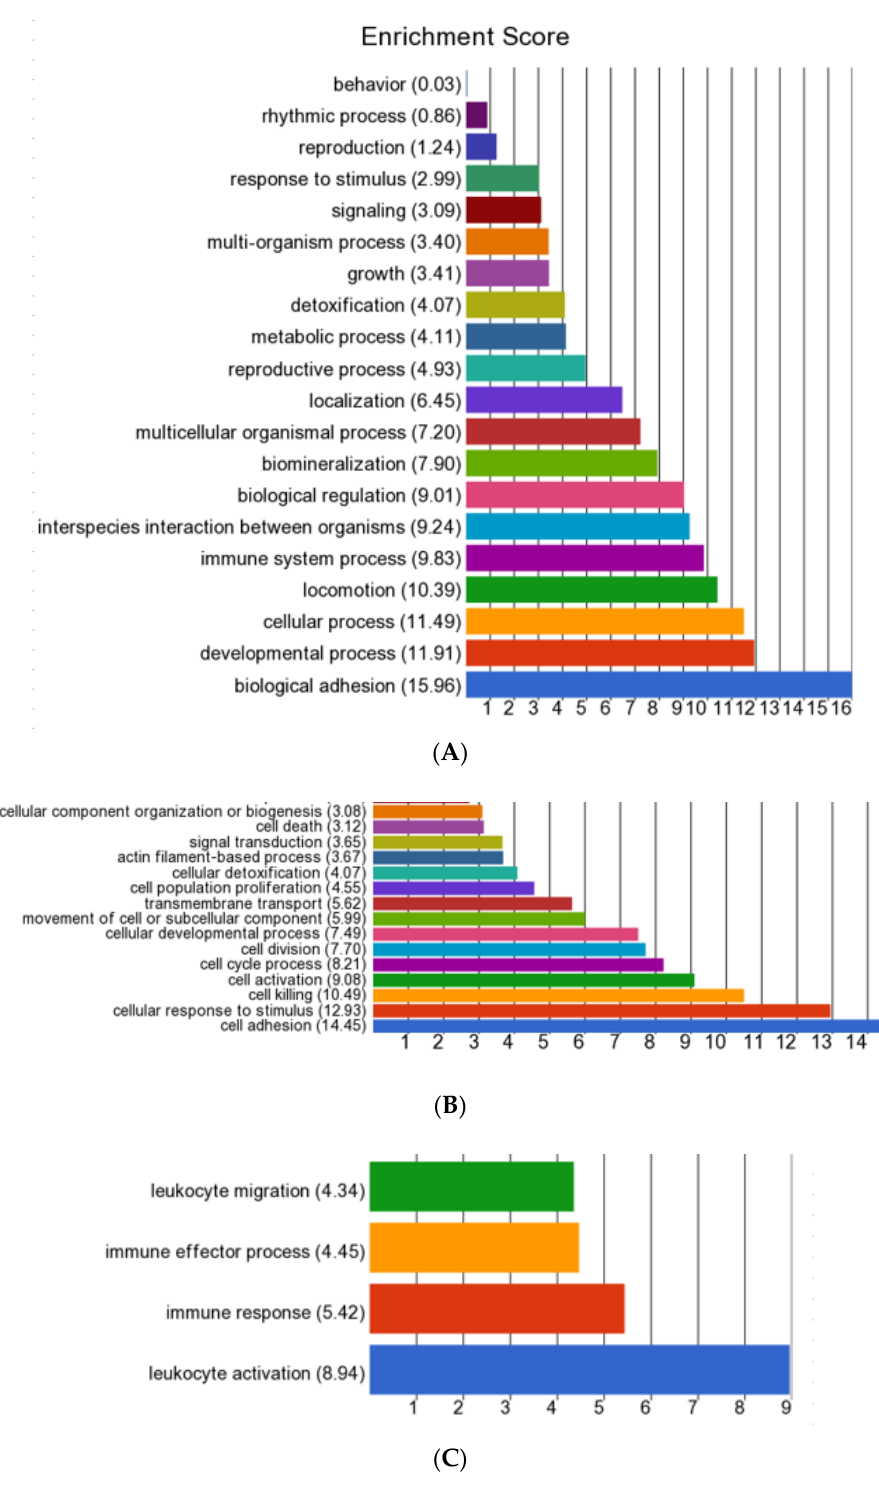
Figure 3. Summary of Gene Ontology (GO) enrichment analysis of the biological functions activated in the E. coli (+) EARLY cows in comparison with the E. coli (-) CONT cows (each n = 6). ( A ) All biological functions identified from the list of all up-regulated differentially expressed genes (DEGs, n = 1090); ( B ) sub-categories with an enrichment score (ES) >3 in the main pathway “Cellular process”; and ( C ) sub categories with an ES > 3 in the main pathway “Interspecies interaction”.